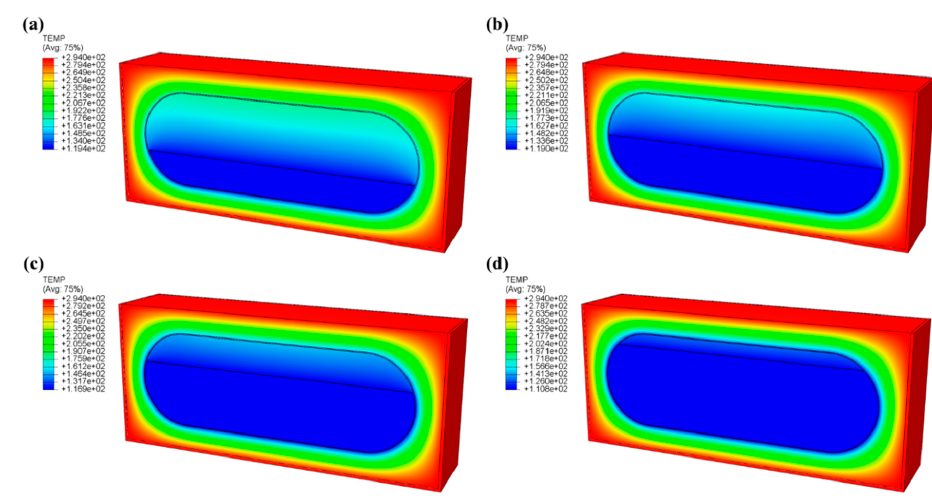
Figure 9. Vertical temperature profile over